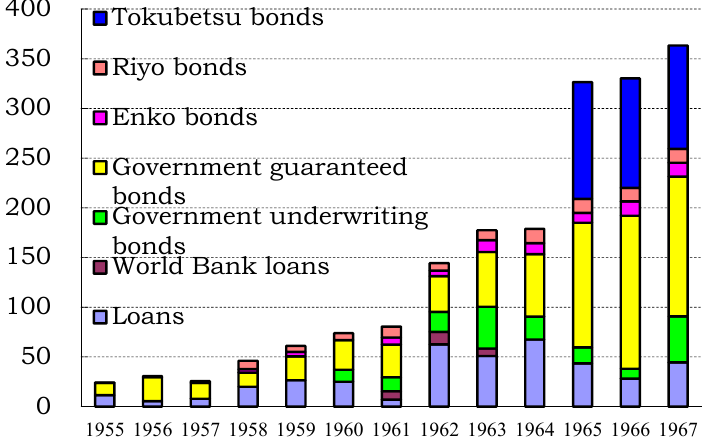
Figure 2. Capital financing from outside JNR (in fiscal years) Source: Takahashi (2000, Figure 1-2).